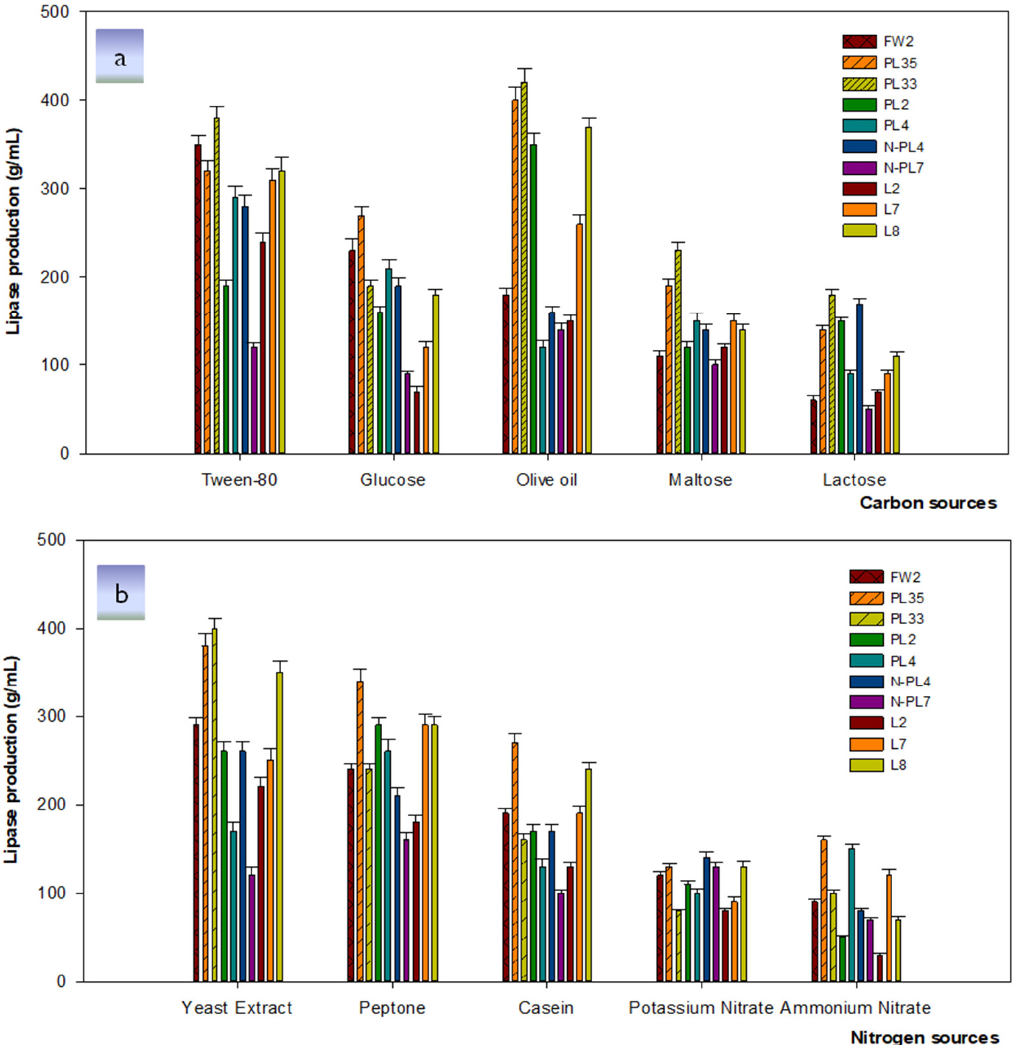
Figure 4. The influence of carbon ( a ) and nitrogen sources ( b ) on lipase activities. Samples were incubated 30 °C for 72 h. Experiments were performed in triplicate.